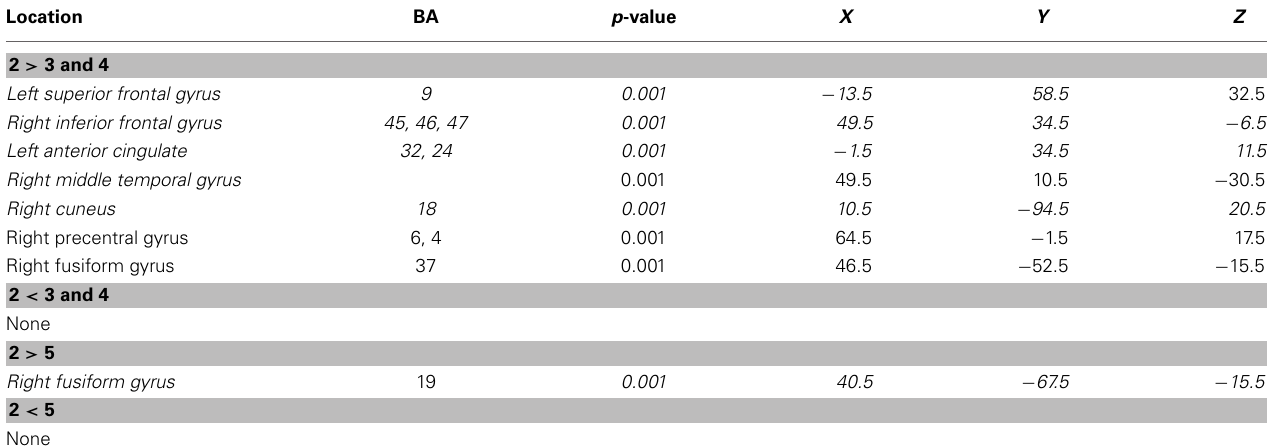
Table 1 | Regions identified during serial position contrasts in the JOR task.